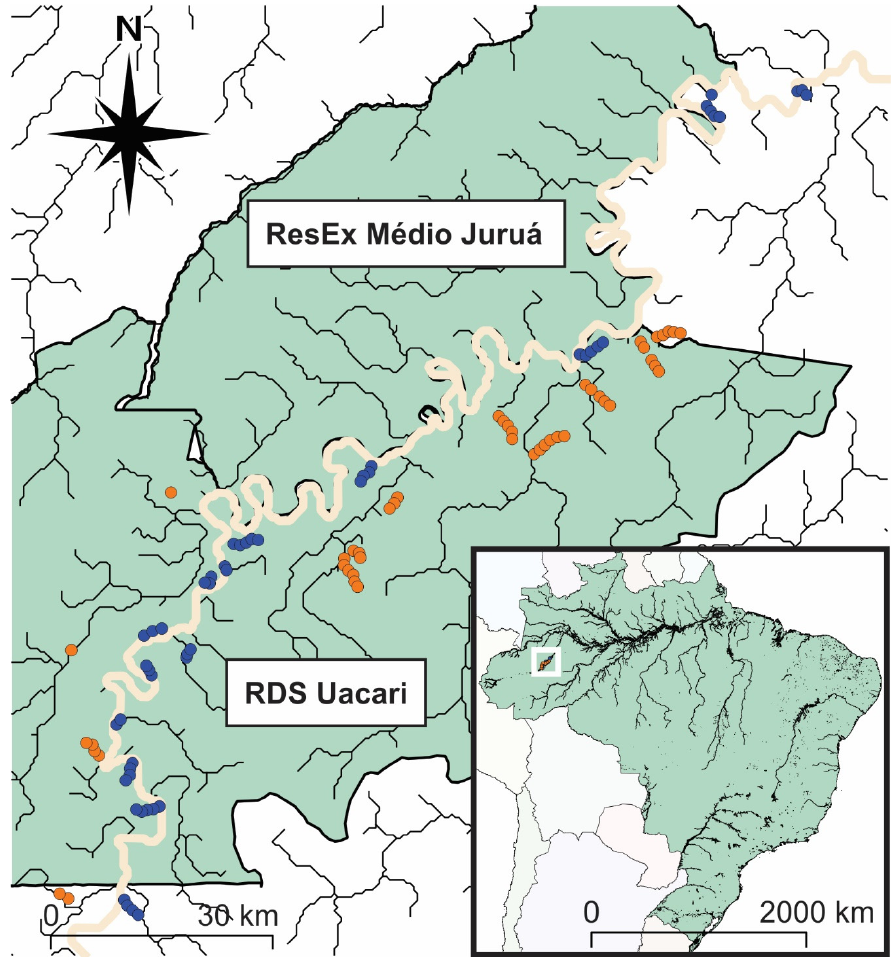
Figure 1. Map showing the study area in western Brazilian Amazonia (indicated by the white square in the inset map) and plot locations of woody plant inventories in terra firme (orange) and várzea forests (dark blue) along 150 km of the Juruá River (in beige). Smaller rivers are shown as black lines. The Médio Juruá Extractive Reserve (ResEx Médio Juruá) and Uacari Sustainable Development Reserve (RDS Uacari) are shown in green with black borders. The map was generated in QGIS v.3.12.2, using background maps from the GADM database of Global Administrative Areas [32]. The shapefiles for the ResEx M é dio Juru á and RDS Uacari were provided by Instituto Chico Mendes de Conservaç ã o da Biodiversidade (ICMBio) and the Amazonas State Environmental Agency (SEMA-DEMUC),